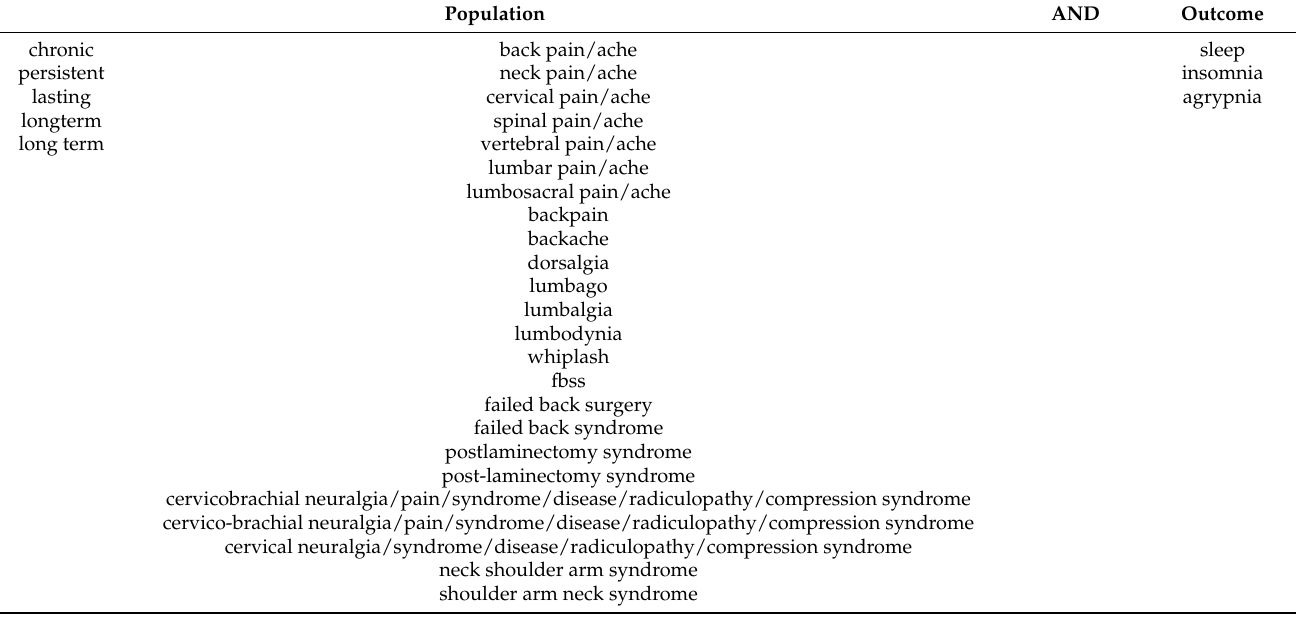
Table 1. Free text words used to build the search